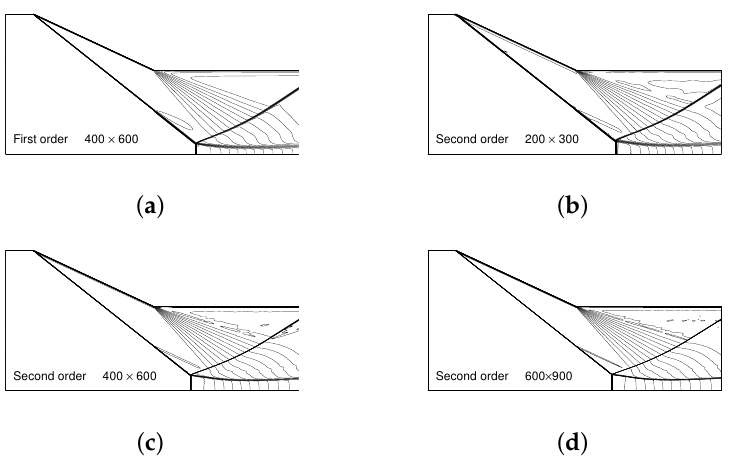
= 0.6: ( a ) first order with a 400 × 600 H A